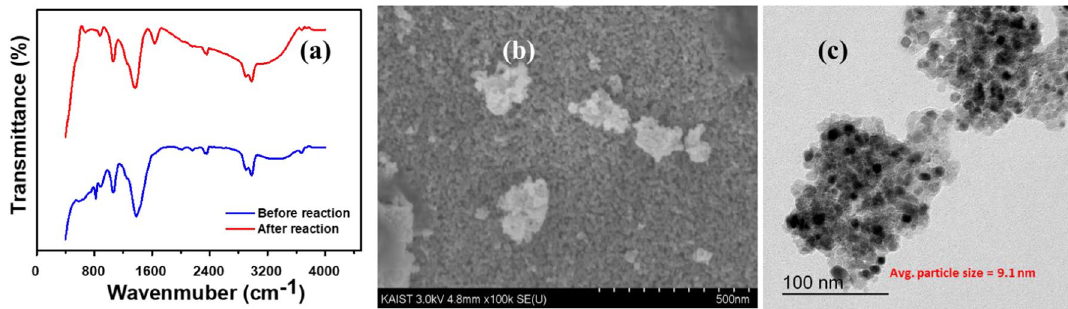
Figure 11. ( a ) FTIR spectra of PdO–NiO nanocomposite before and after reducing the mixture of azo compounds ( b ) FE-SEM image ( c ) HR-TEM image of PdO–NiO after reducing the mixture of azo